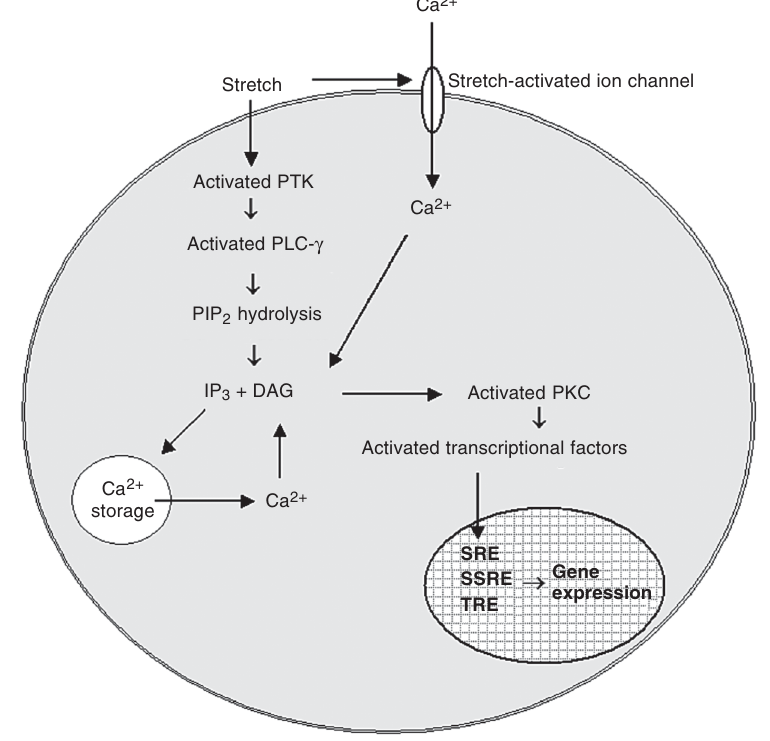
Figure 1. Mechanically activated ion channel pathway. Stretch induces Ca 2+ influx via a stretch-activated ion channel. Mechanical stretch also activates protein ty- rosine kinases (PTK) that activates phospholipase C- γ (PLC- γ ) via its tyrosine phosphorylation. PLC- γ medi- ates the hydrolysis of phosphatidylinositol 4,5-bisphos- phate (PIP 2 ) to produce inositol 1,4,5-trisphosphate (IP 3 ) and diacylglycerol (DAG). IP 3 mobilizes Ca 2+ from intracellular storage sites. DAG in the presence of in- tracellular and extracellular Ca 2+ activates protein ki- nase C (PKC). PKC and other signals may activate transcriptional factors (c- fos ) that bind to special re- sponse elements, such as stretch response elements (SRE), shear stress response elements (SSRE) and shear 12-O-tetradecanoylphorbol 13-acetate (TPA)-re- sponsive element (TRE), boosting gene